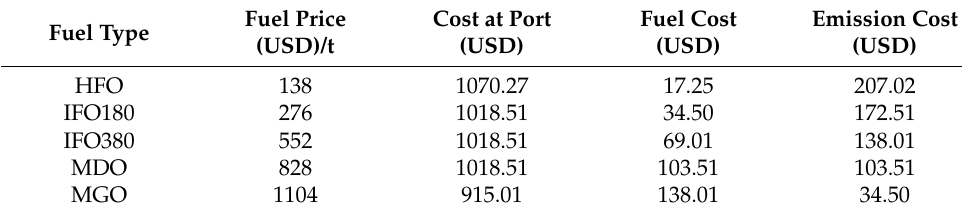
Table 5. The results of the first stage considering different fuel prices *